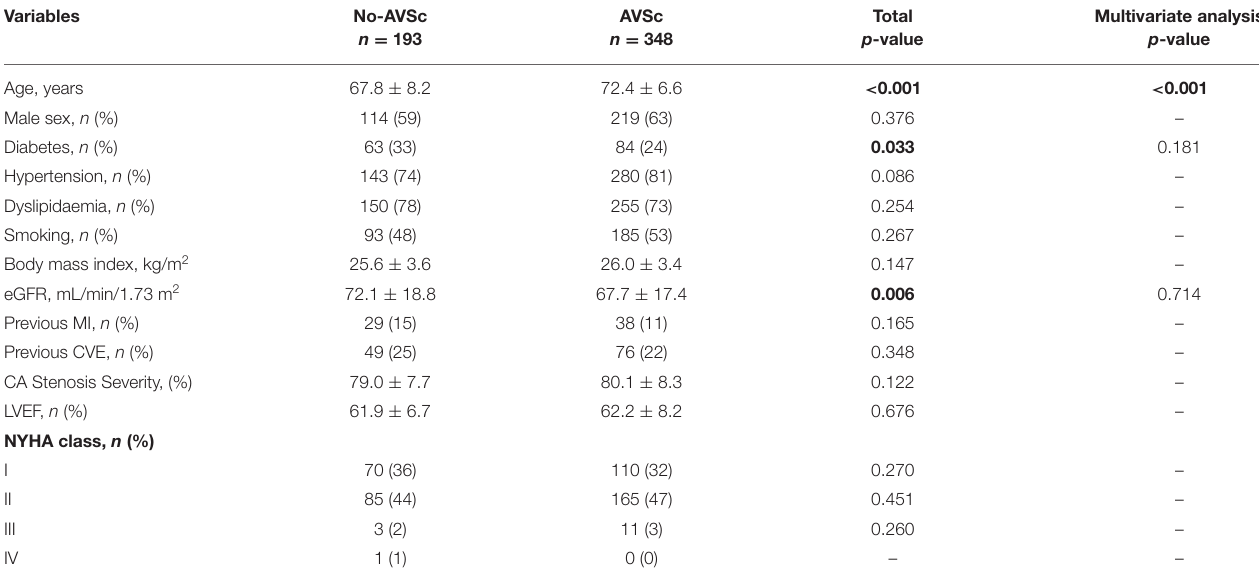
TABLE 1 | Baseline characteristics of the patients undergoing CEA, stratified accordingly to normal aortic valve morphology (No-AVSc) and aortic valve sclerosis (AVSc).